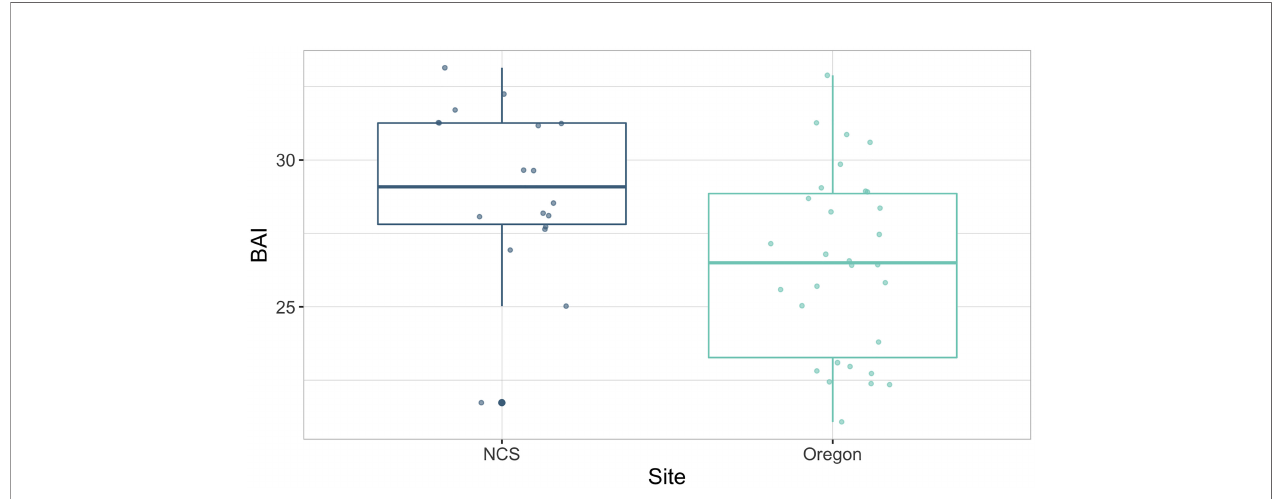
FIGURE 5 | Boxplots illustrating the distribution of Body Area Index (BAI) values of gray whales imaged by survey plane in the Northeastern Chukchi Sea (NCS) of the Arctic and by UAS in Oregon. Data are grouped by site. The group median (horizontal line), interquartile range (IQR, box), maximum and minimum 1.5*IQR (vertical lines), and outliers (dots) are depicted in the boxplots. The overlaid points represent the BAI values from each image.